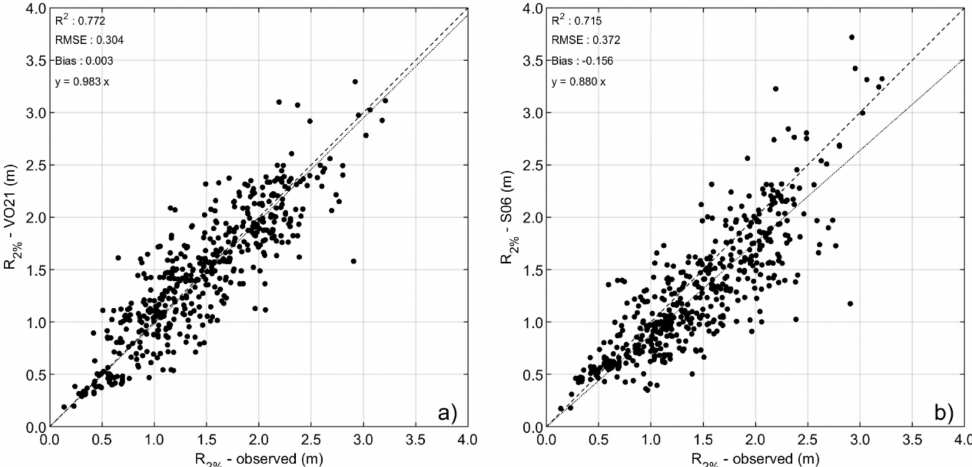
Figure 16. Comparison of S06 R 2% run-up observations of VO21 formulations ( a ) and S06 formulations ( b ). Dashed lines indicate unity (y = x) and solid lines are linear regression lines y = ax.